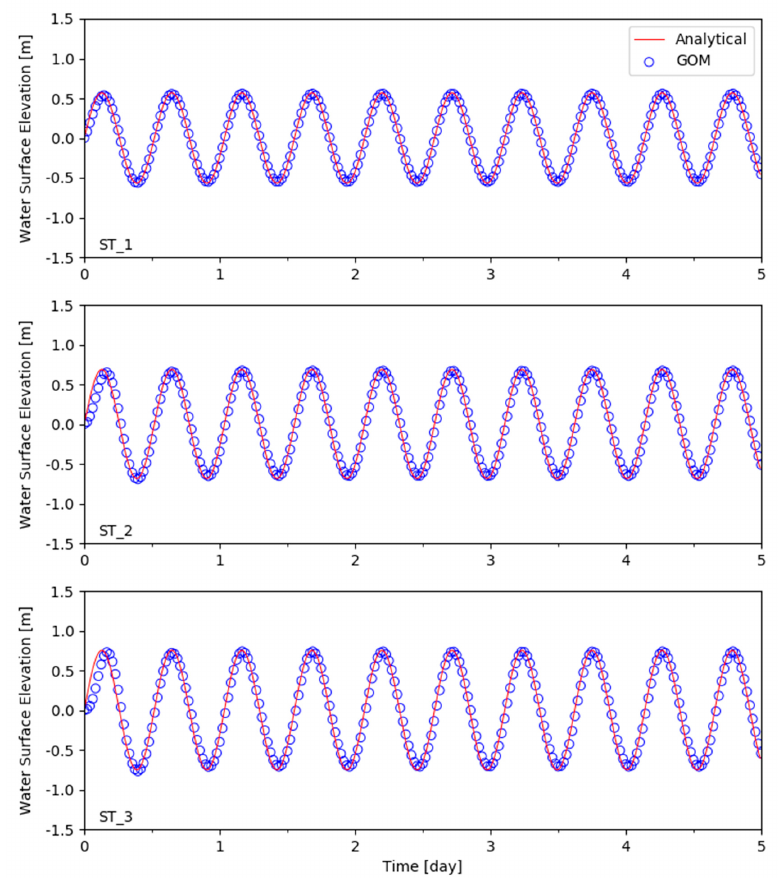
Figure 9. Comparison of water surface elevation for tidal propagation test at three locations with θ = 1.0. Solid lines and circles represent analytical solutions and numerical results, respectively. ST_1, ST_2, and ST_3 denote result extraction locations shown in Figure 8.